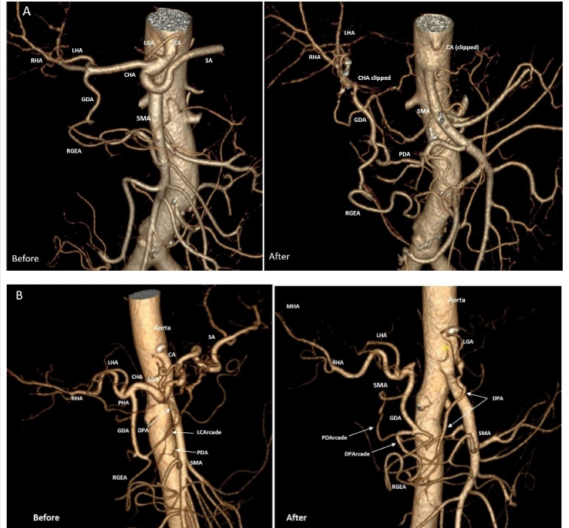
Figure 5. Ductal adenocarcinoma of the pancreatic body. Three-dimensional computed tomography angiography (CTA) . Michels I anatomy. ( A ) Typical CTA after DP CAR with the left gastric artery (LGA) excision in a 66-year-old male. Before surgery: the pancreatoduodenal arcade is open, pancre- atoduodenal artery (PDA) is invisible on CTA due to its small diameter (1.96 mm) and view; Seven days after surgery: pancreatoduodenal arcade is closed, PDA originates from the 1st intestinal branch, well visible (3.3 mm) and it is the sole artery supplying the liver and stomach. ( B ) CTA after DP CAR with preservation of LGA and dorsal pancreatic (DPA) arteries in a 71-year-old female (not included in the study). Before surgery: the pancreatoduodenal arcade is open; PDA and DPA are small diameters and do not form arcades. The arcade of the lesser curvature (LCArcade) is well seen. Ten days after surgery: LCArcade has disappeared (excised). There are two closed arcades: (1) from DPA to gastroduodenal (GDA) artery—DPArcade and (2) pancreatoduodenal arcade. The DPArcade is much more powerful than PDArcade and looks like the primary collateral to the liver and partly to the stomach (due to the widening of the right gastroepiploic artery (RGEA). This picture shows that expectations for the significant widening of the PD arcade after preoperative CHA embolization (PO CHAE) can be not lived up due to the existence of alternative ways for the liver and stomach supply besides PDA, and these alternative collaterals can be excised during DP CAR (here there are LC Arcade and DP Arcade), i.e., PO CHAE, in this case, can be non-preventive for stomach and liver ischemia. RHA: right hepatic, SMA: superior mesenteric, LHA: left hepatic, CHA: common hepatic, SA: splenic, CA: celiac